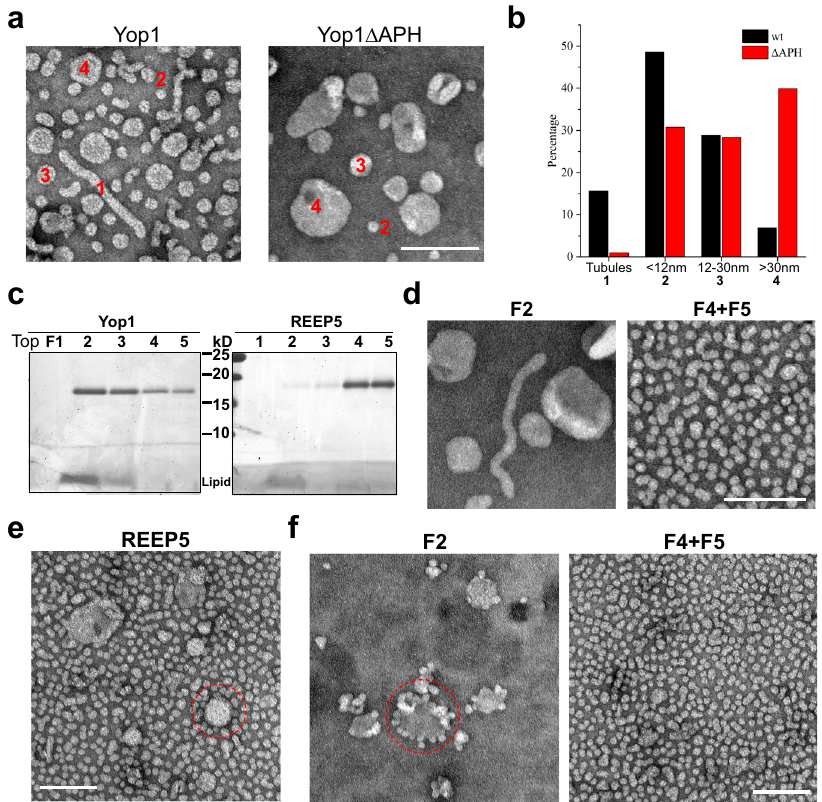
Fig. 3 Reconstitution of puri fi ed REEPs generates high-curvature structures. a Yop1 or Yop1 Δ APH were puri fi ed from DDM-solubilized membranes and reconstituted with S. cerevisiae lipids at a molar ratio of 1:200 protein:lipid. The samples were analyzed by negative-stain EM. Short tubules (1), vesicles with diameters <12 nm (2), vesicles with diameters 12 – 30 nm (3), and vesicles with diameter >30 nm (4) are highlighted. b Quanti fi cation of experiments as shown in a ( n = 2664 for wt and 2632 for Δ APH from three independent experiments). c Yop1 or Xenopus REEP5 were reconstituted with S. cerevisiae lipids at a molar ratio of 1:200 protein:lipid. The samples were subjected to fl otation in a Nycodenz gradient, and fractions were analyzed by SDS-PAGE and Coomassie-blue staining. The band at the bottom is lipid. d The indicated fractions of the Nycodenz fl otation of Yop1 in c were analyzed by negative-stain EM. e Negative-stain EM analysis of Xenopus REEP5 after reconstitution, but before fl otation. f Fractions of the Nycodenz fl otation of Xenopus REEP5 in c were analyzed by negative-stain EM. Dashed circles in e and f highlight LPPs budding off from large proteoliposomes. All experiments were performed three times. Bars, 100